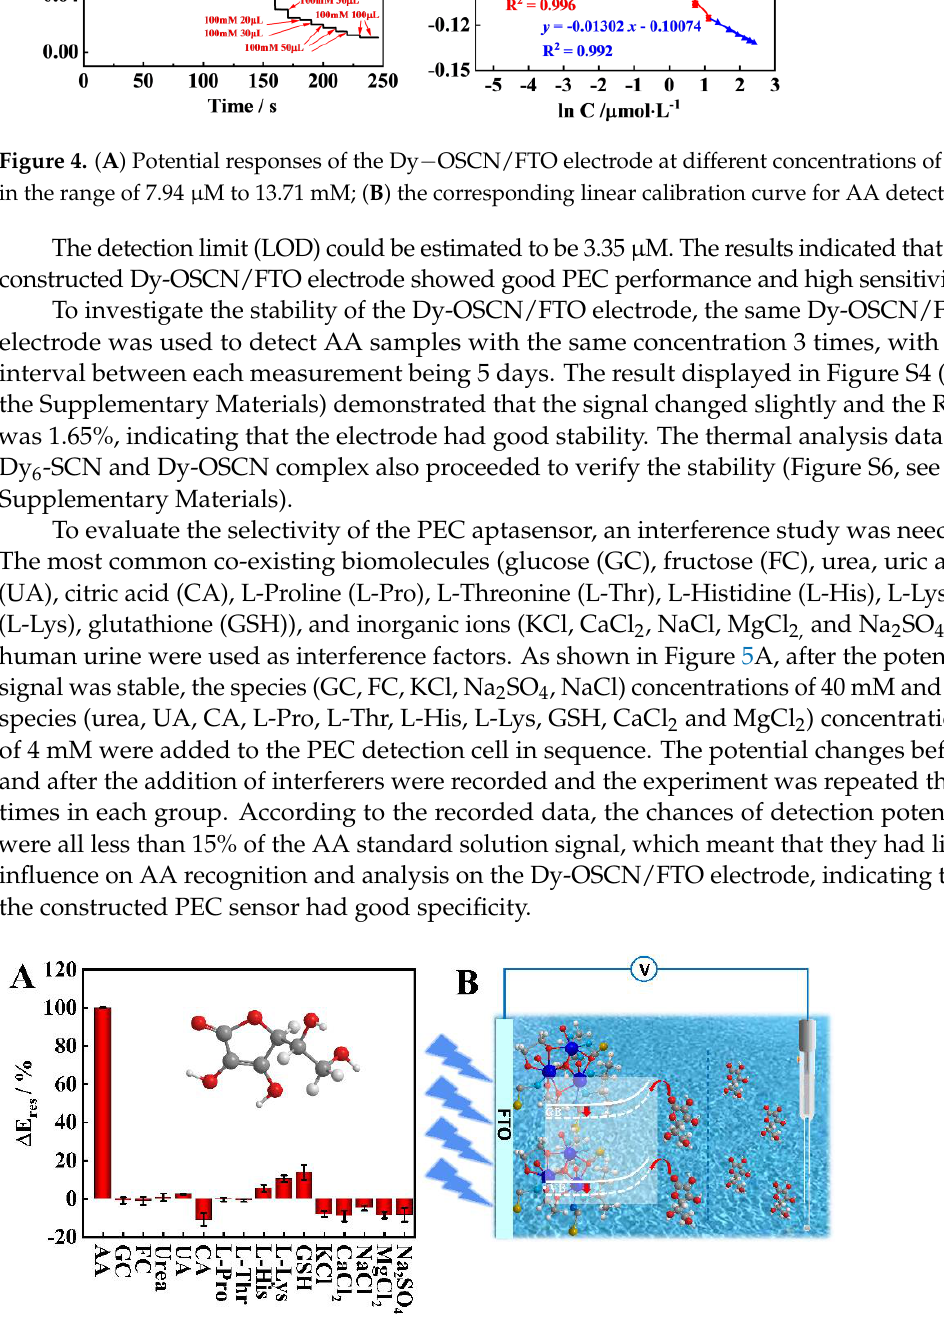
Figure 5. ( A ) Selectivity of the PEC sensor to AA interferes including GC, FC, urea, UA, CA, L-Pro, L-Thr, L-His, L-Lys, GSH, KCl, CaCl 2 , NaCl, MgCl 2 and Na 2 SO 4 ; ( B ) diagram of possible detection mechanism of AA on enzyme-free Dy-OSCN/FTO PEC sensor.